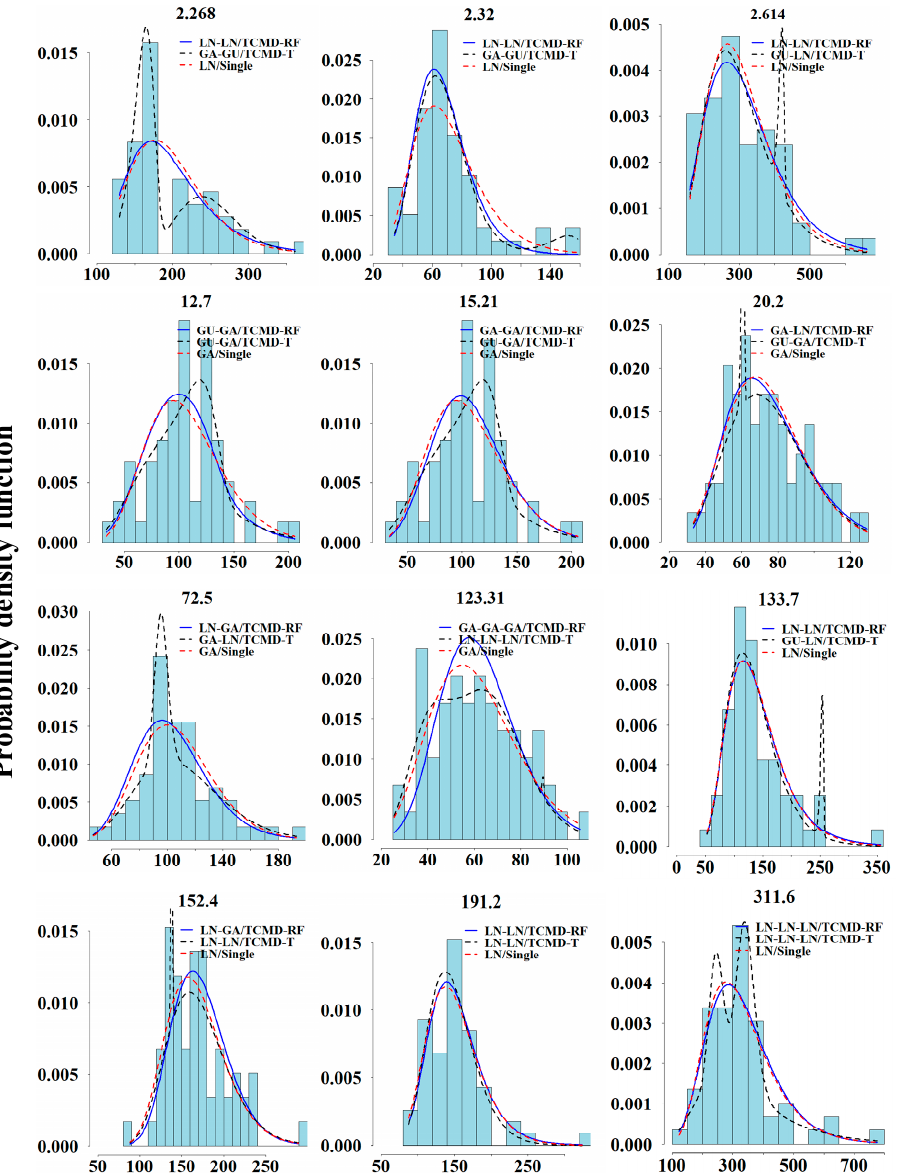
Figure 9. Histogram of floods and probability density function of TCMD-T, TCMD-RF and single distribution.